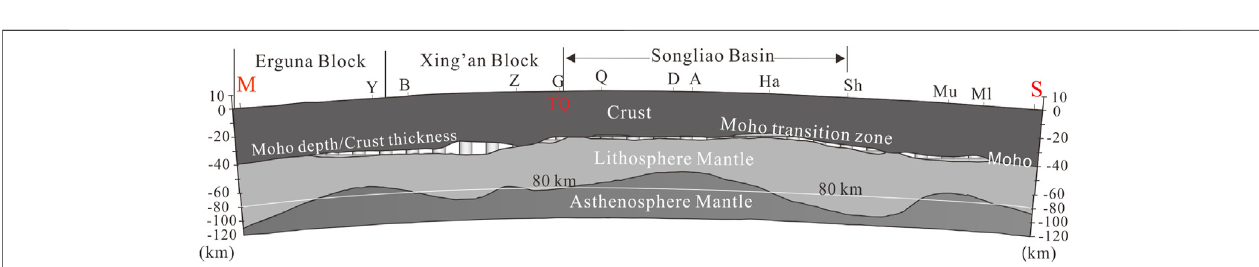
FIGURE 11 | Underlying crust and lithospheric and asthenospheric mantle of the Songliao Basin along the GGT (according to Wang et al., 2016). Cities: M, Manzhouli; Y, Yakeshi; B, Boketu; Z, Zhalantun; TQ, Tuquan; G, Gannan; Q, Qiqihaer; D, Daqing; A, Anda; Ha, Harbin; Sh, Shangzhi; Mu, Mudanjiang; Ml, Muling; S, Suifenhe.